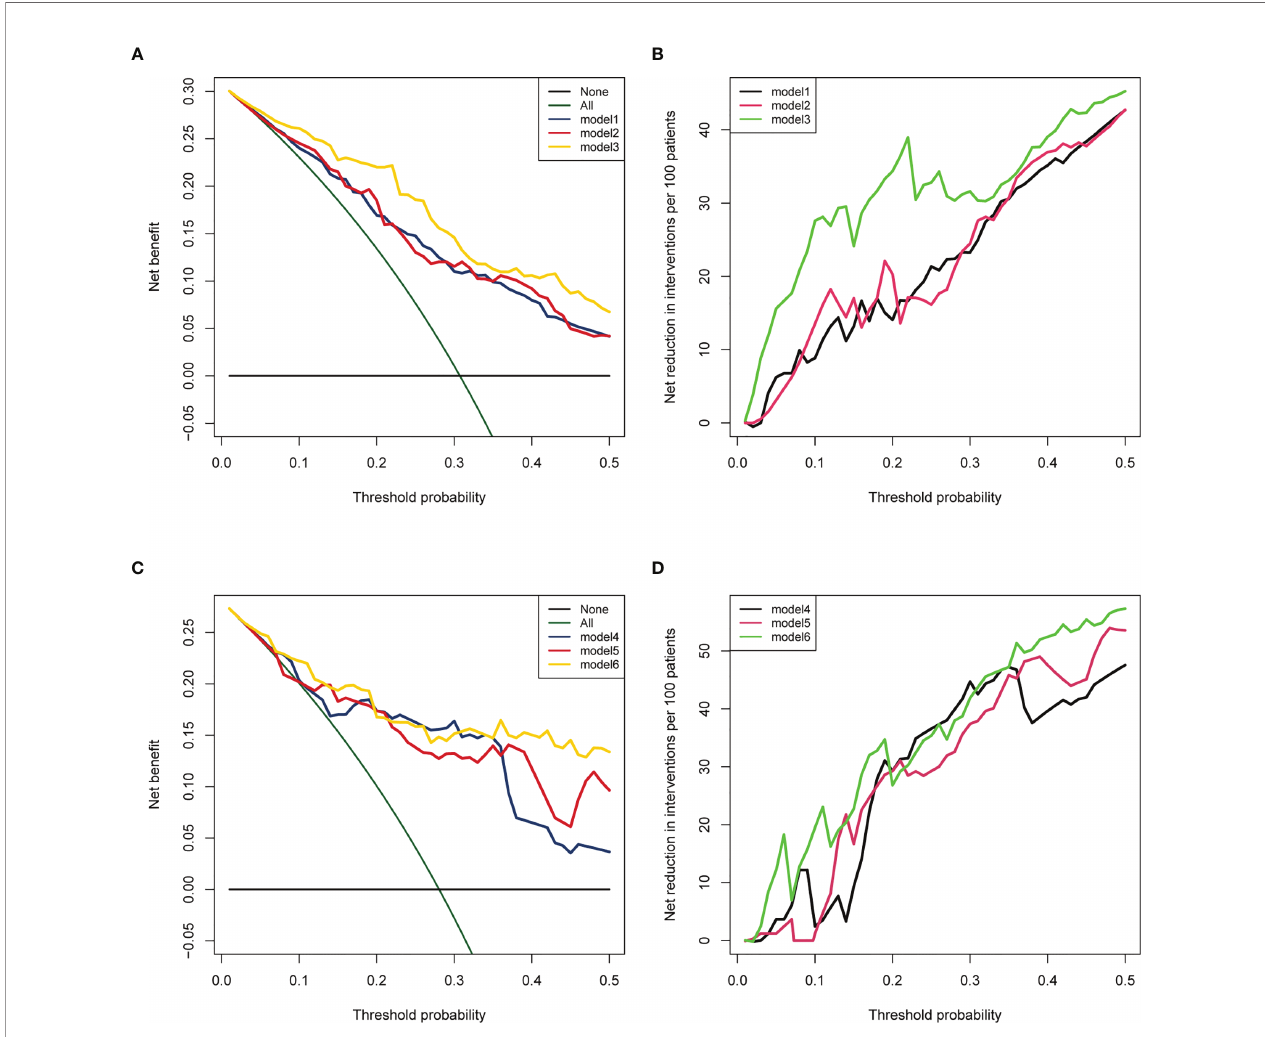
FIGURE 3 | Clinical decision curve analysis demonstrates the clinical bene fi ts of the clinical prognostic model for predicting WHO grade II meningiomas progression. (A) Net bene fi t curve in the training cohort; (C) Net bene fi t curve in the test cohort: The green line represents the net bene fi t of providing all patients with the intervention (such as high frequency of follow-up, postoperative radiotherapy, drug, and even biopsy), regardless of whether the tumor progression or not. Some patients without tumor progression underwent unnecessary intervention. The black line represents the net bene fi t of providing no patients with intervention, regardless of whether the tumor progression or not, so the net bene fi t was 0. The blue line (model 1 and model 4) represents the net bene fi t of individualized intervention after using the hematological risk model to assess the progression probability; model 2 and model 5 (red line): clinical prognostic factors; model 3 and model 6 (yellow line): clinical prognostic model. (B) Net reduction curve in training cohort; (D) Net reduction curve in test cohort: the net reduction curves reveal how many patients can avoid unnecessary intervention (such as high frequency of MRI examination) per 100 patients without missing any meningioma progression during the follow-up period, in the basis of decision derived from HRM (black line), clinical factors (brick red line), and clinical prognostic model (green